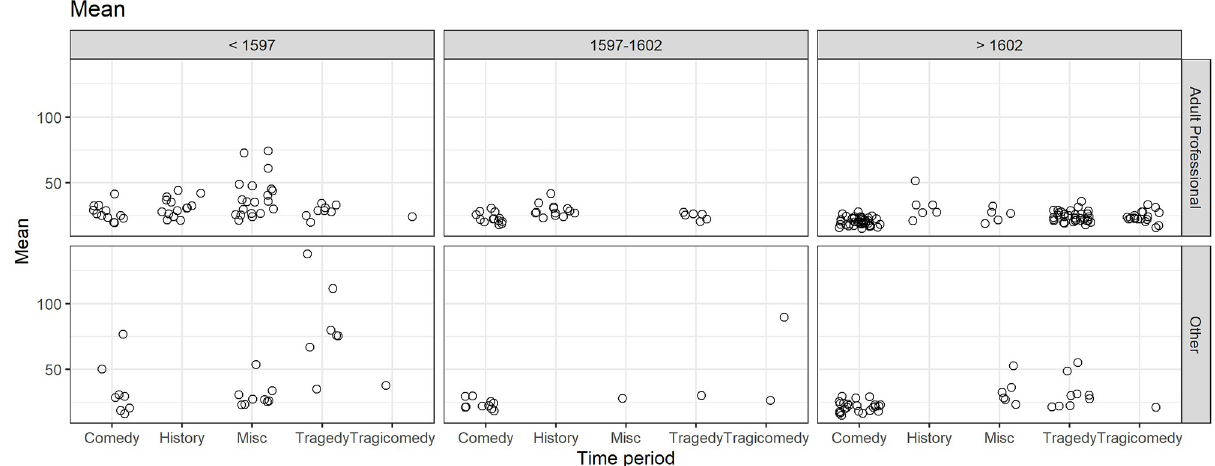
Fig 12. (S1 Fig 14 in S1 File) Mean speech length of plays in genre, play type and period groupings.